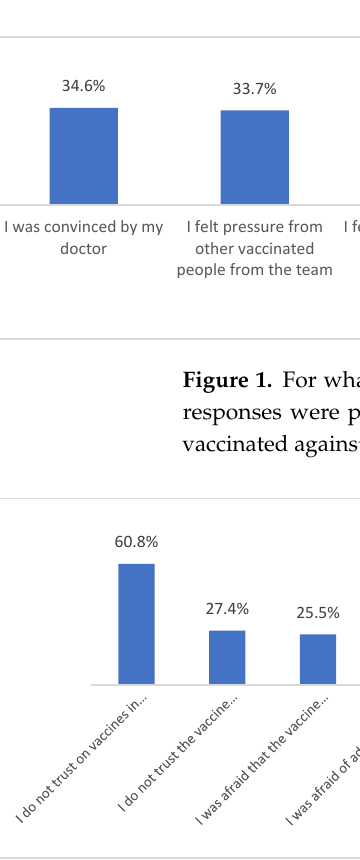
Figure 2. For what reason did you not get vaccinated against COVID-19? ( n = 212) Multiple-choice responses were presented in the questionnaire only for those who declared that they had not been vaccinated against COVID-19. Seven in ten athletes surveyed (70.1%, n = 627) stated that their coaches were vacci- nated against COVID-19. Only 3.7% ( n = 33) stated that their coaches were not vaccinated, and one in four (26.3%, n = 235) did not know. Coaches of VA athletes were more likely to be vaccinated than those of NVA athletes (77.5% vs. 46.2%, respectively; p < 0.001) (Table 3). Table 3. Is your coach vaccinated against COVID-19? Responses broken down by vaccinated (VA, n = 683) and unvaccinated (NVA, n = 212) against COVID-19.